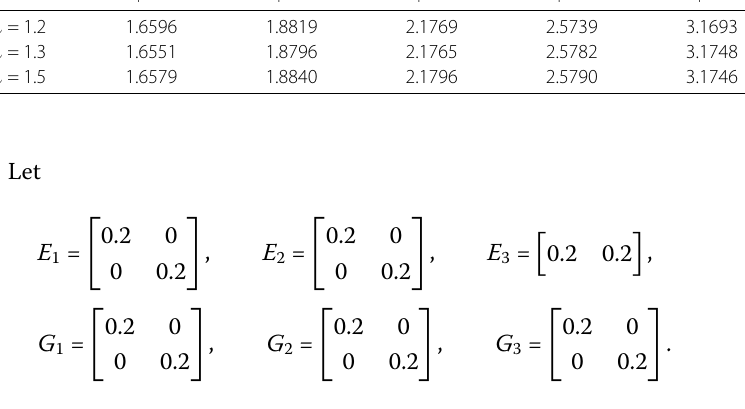
Table 3 Maximal allowable upper bounds λ 1 for different τ 1 and μ , when d = 0.5 τ 1 = 1.5 τ 1 = 1.3 τ 1 = 1.1 τ 1 = 0.9 τ 1 = 0.7 τ 1 =